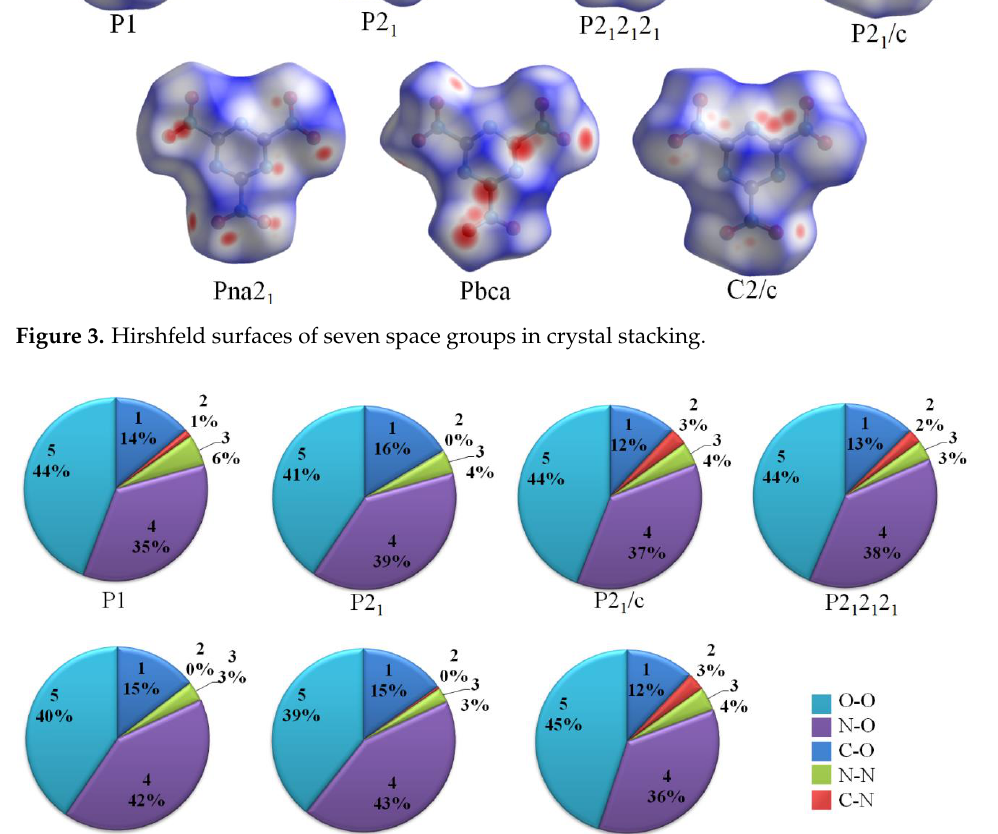
Figure 3. Hirshfeld surfaces of seven space groups in crystal stacking.